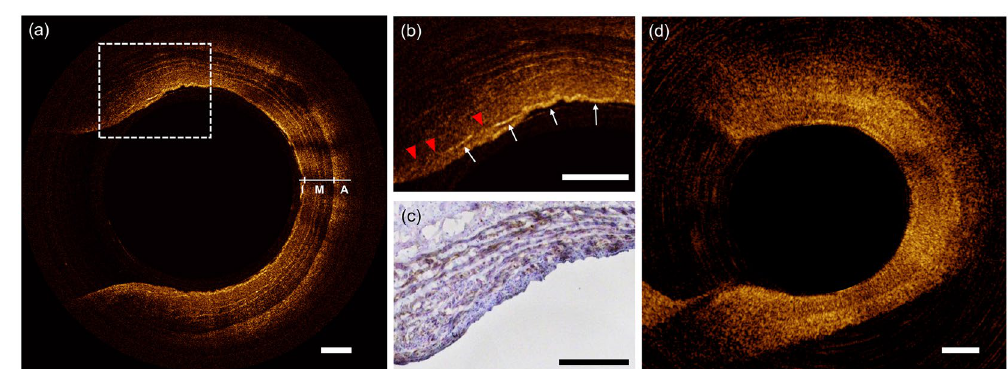
Figure 4. ( a ) µ OCT image of a healthy swine coronary artery shows trilaminar vessel architecture of a muscular artery. I = intima; M = media; A = adventitia. ( b ) High magnification image at the bifurcation demonstrating partial loss (red arrowheads) of IEL (white arrows); ( c ) Corresponding immunohistological staining image for smooth muscle cells ( α -SMA stain); ( d ) Image acquired using conventional OCT. Scale bars, 200 μ